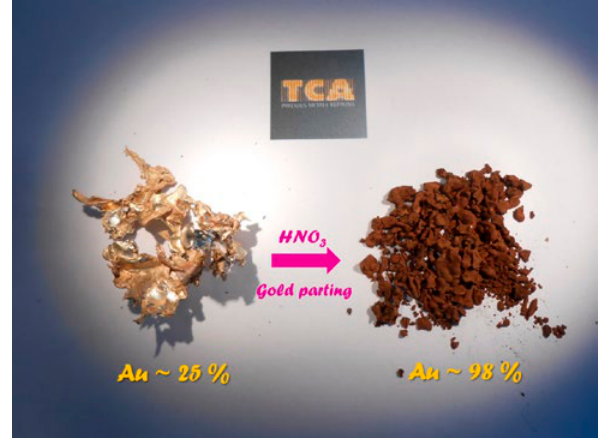
Figure 3. Effect of the silver dissolution by nitric acid on the gold- silver alloy